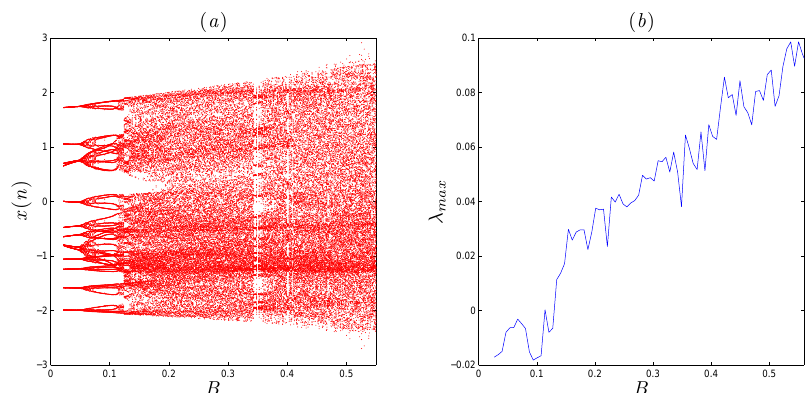
Figure 3. ( a ) The bifurcation diagram versus B , when A = 0.7, γ = 0.98 and let n = 1500. ( b ) The LLE in accordance with diagram ( a ).